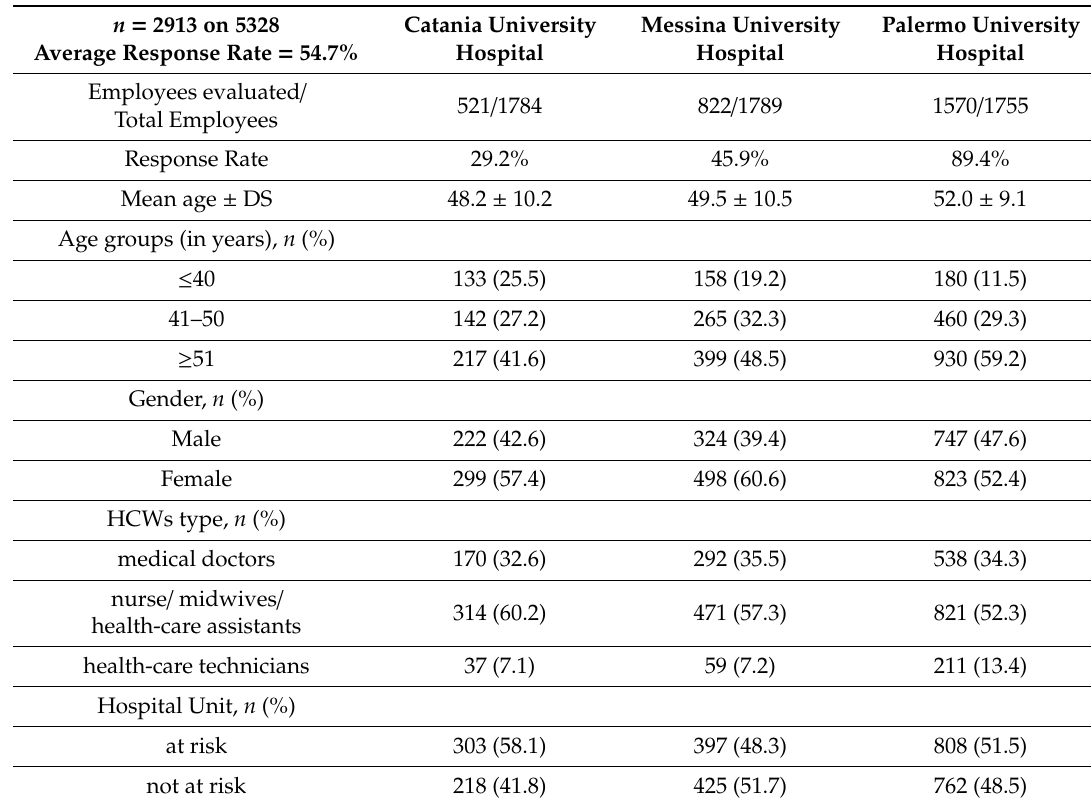
Table 1. Socio-demographics and working characteristics of Healthcare Workers involved in the evaluation of the measles immunization and vaccination status at the three Sicilian university hospitals ( n = 2913). n = 2913 on 5328 Average Response Rate =